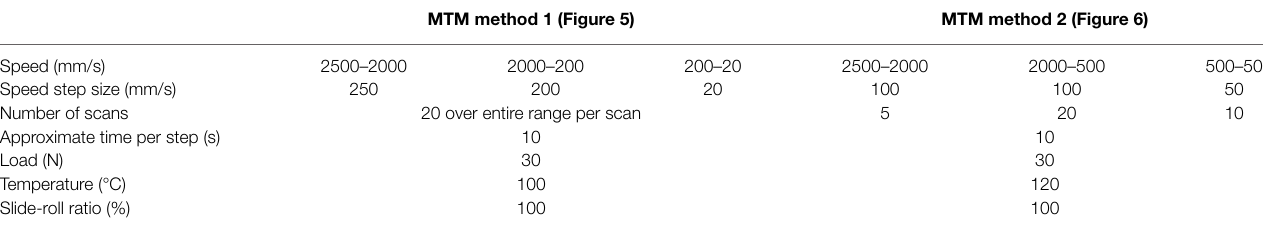
TABLE 4 | Test parameters for MTM Stribeck scan experiments